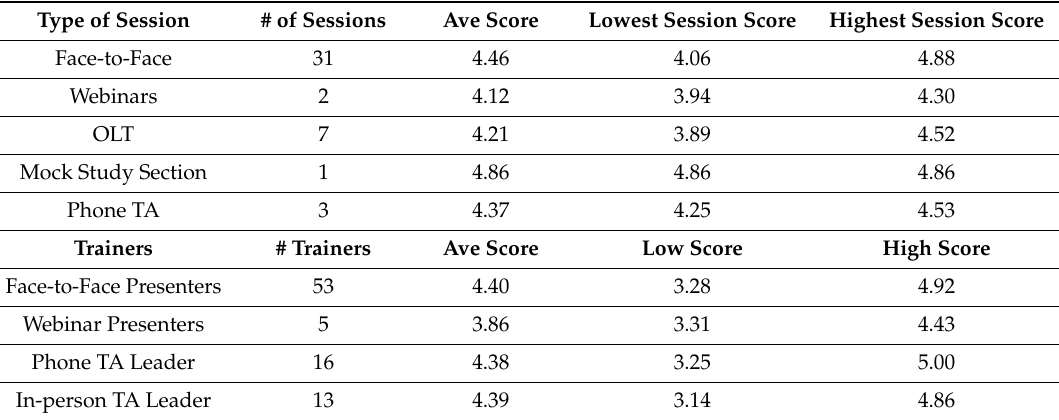
Table 2. CRIBS training sessions and trainer